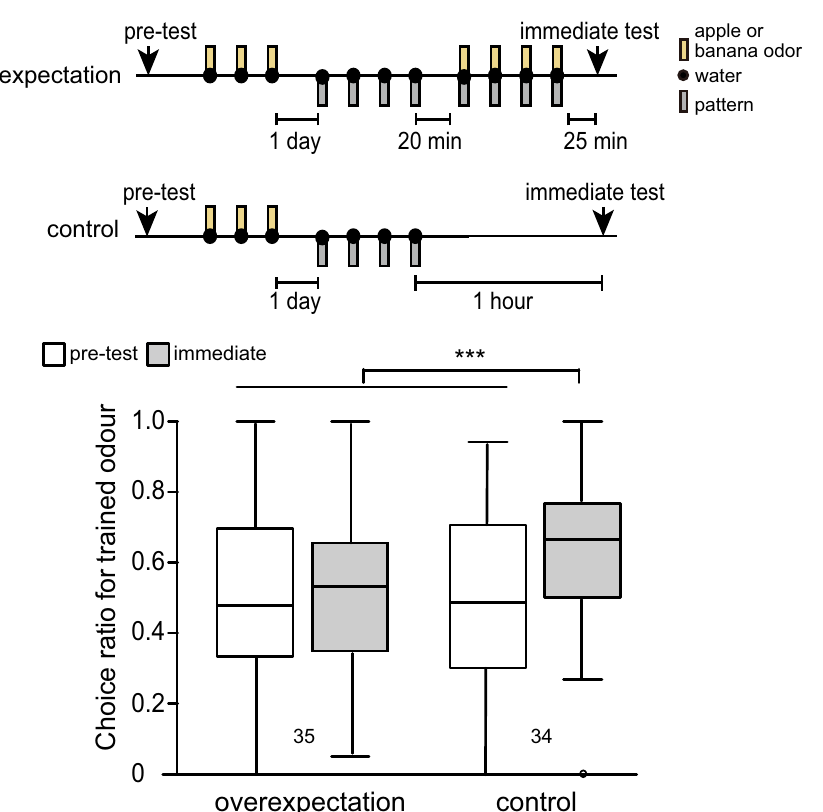
Figure 2. Results of Experiment 1: Overexpectation of olfactory learning in crickets. Crickets in the overexpectation group (n = 35) were subjected to 3 conditioning trials in which an odour was paired with water (O+ training). To counterbalance for the odours used, half of the crickets were trained with either apple or banana odour as the CS. On the next day, they were subjected to 4 conditioning trials in which a white-centre and black-surrounding visual pattern was paired with water (P+ training). After 20 min, they were subjected to 4 odour-visual pattern compound conditioning trails (OP+ training). Crickets in the control group (n = 34) were subjected to 3 O+ training trials and 1 day later they were subjected to 4 P+ training trials. The ITI was 5 min. Relative odour preference was tested before training (pre-test) and immediately after training (immediate test). The latter is 1 h after completion of P+ training in both groups, which matches to 25 min after completion of OP+ training in the overexpectation group. The results before (white) and immediately after (light grey) training are shown as box and whisker diagrams. A GLMM was used to examine relative preferences for the conditioned odour (Supplemental Table 1). Statistical significance is shown as asterisks (*** p <